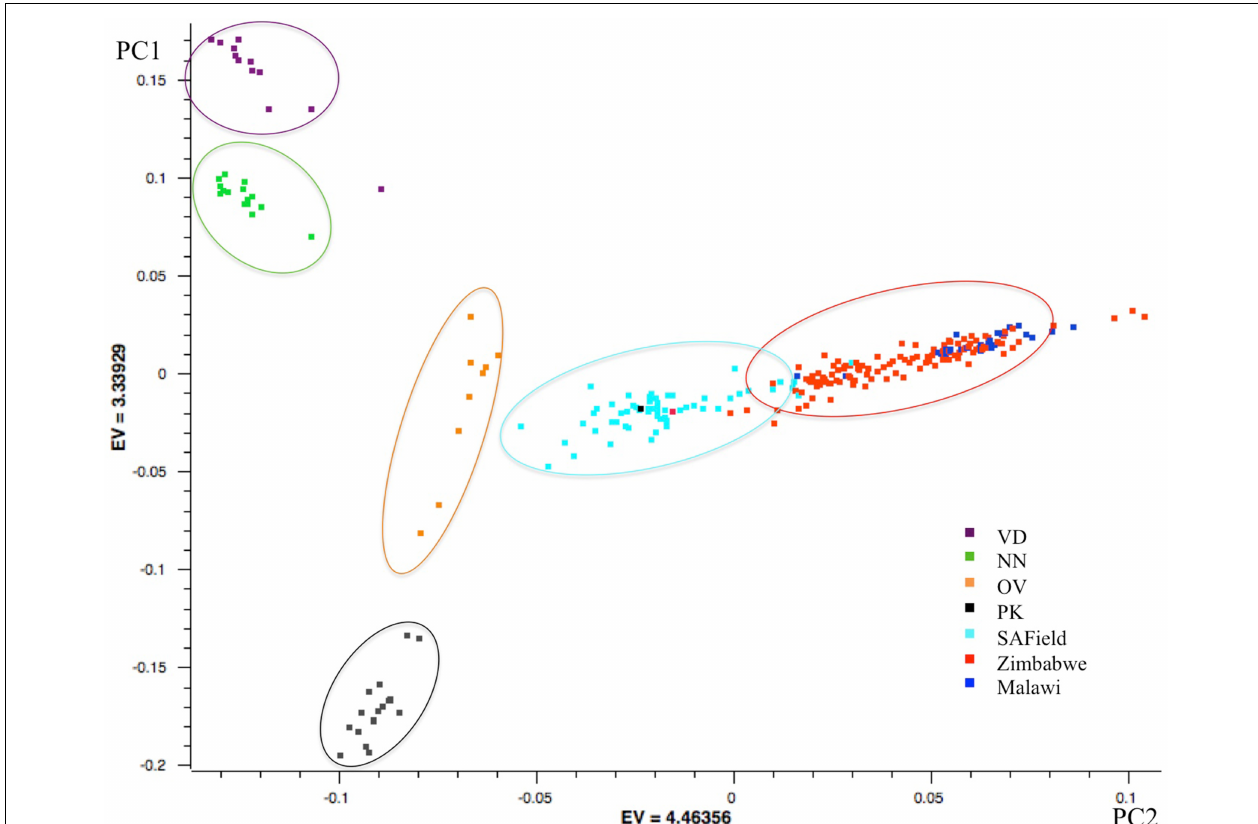
FIGURE 2 | PCA based clustering of populations. Population clusters are within the ovals and the color of each oval represents the predominant chicken population. VD, Venda conservation flocks; NN, Naked Neck conservation